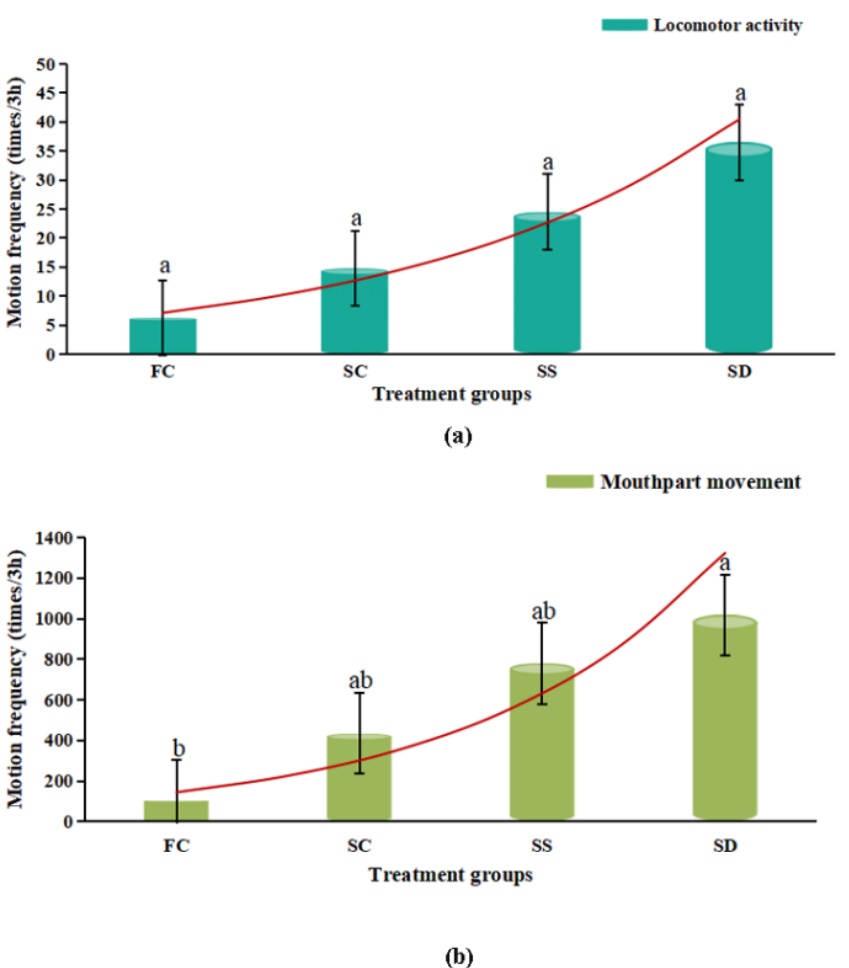
Figure 3. Locomotor activity ( a ); and mouthpart movement ( b ); in Eriocheir sinensis during 3 h exposure in four treatment groups (FC: freshwater control group; SC: salinity control group; SS: salinity surge group; SD: salinity dip group), and the red curve represents the exponential trend line. Bars with the same lowercase letters on the top indicate insignificant differences ( p > 0.05), and bars with different letters on the top indicate significant differences ( p < 0.05).